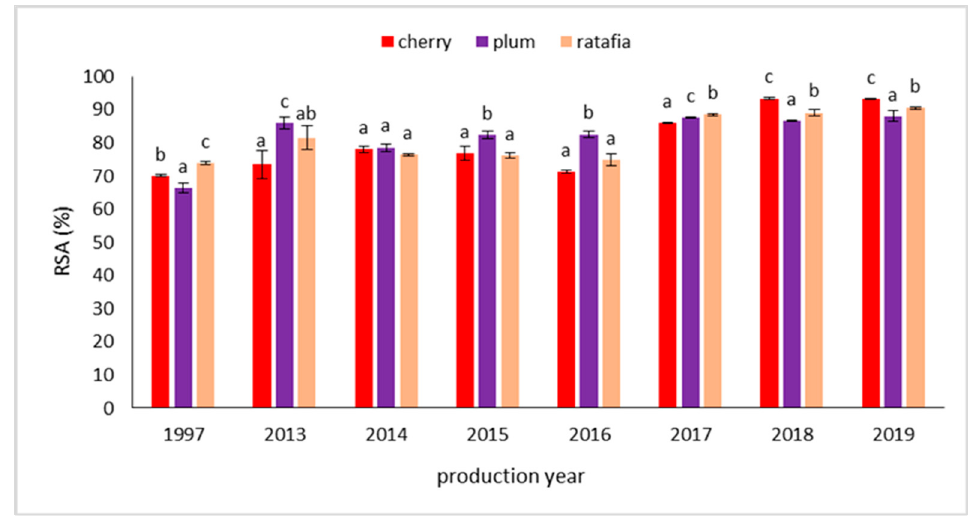
Figure 3. Percentage of free radical scavenging by nalewkas in each year of production (mean ± SD, n = 3). The results were calculated based on the DPPH method. Different letters indicate significant differences between the nalewkas in individual years of production.